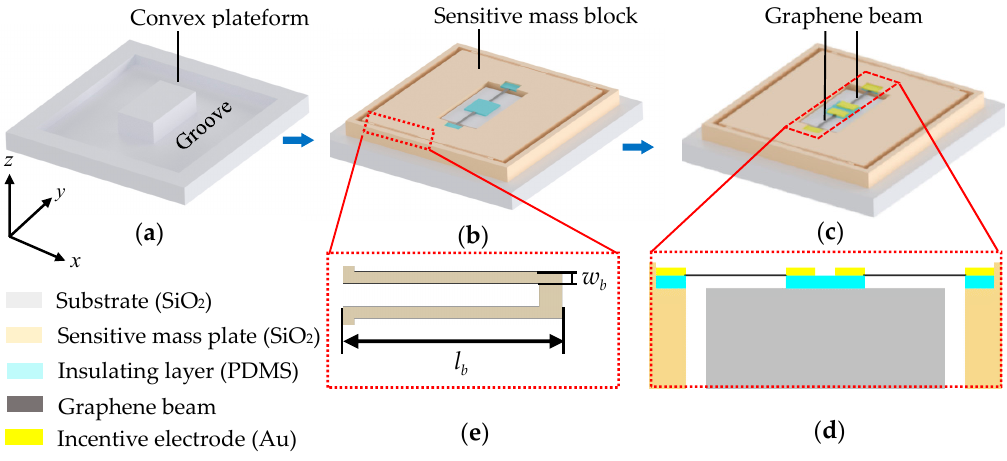
Figure 1. The model of a differential resonant graphene accelerometer. ( a ) The substrate of accelerometer; ( b ) etching sensitive mass plate and preparing insulating layers and graphene beams; ( c ) fabricating the integrated accelerometer; ( d ) enlarged y – z cross-sectional view of the central area of accelerometer; ( e ) partial enlarged drawing of one side folded support beam in inset.